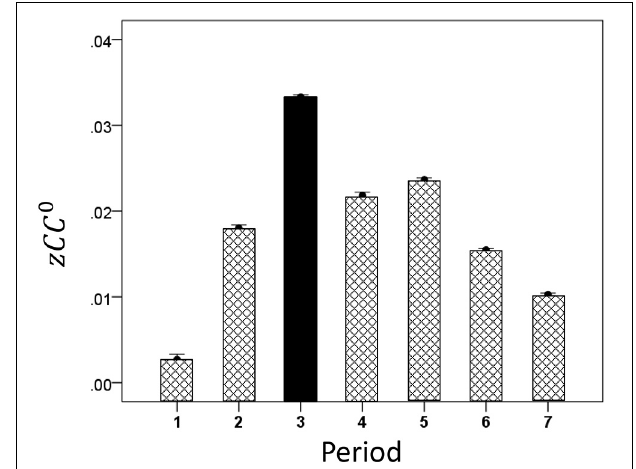
FIGURE 7 | Mean modulation ( ± s.e.m.) of opposite-hemispheres zCC 0 during task periods, peaking at period 3 (see text for